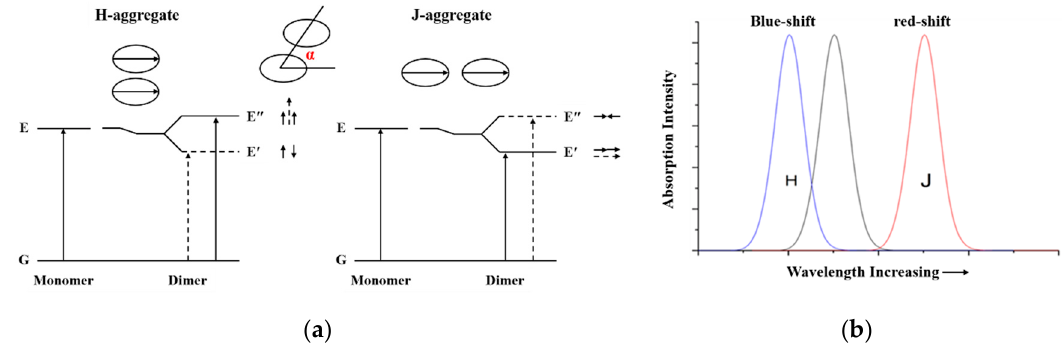
Figure 2. ( a ) Schematic of exciton theory for a molecular dimer to explain the changes in the absorption spectrum; ( b ) The relative shift of the absorption intensity for H and J aggregates in relation to their monomeric form.